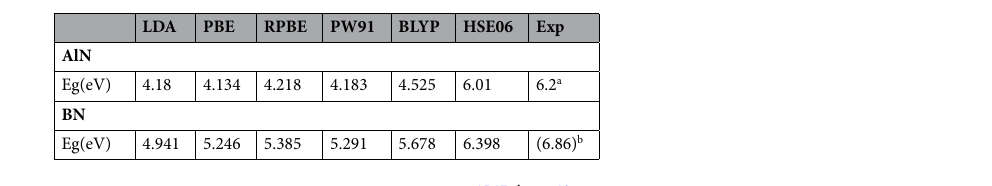
Table 2. calculation results of energy gap. a Ref 15,17 . b Ref 18 . () Means no experimental